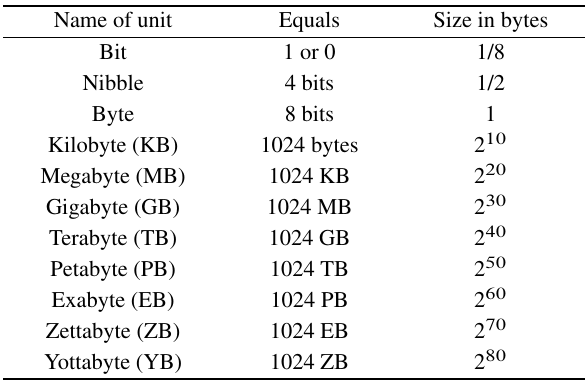
Table 2 Units of data.